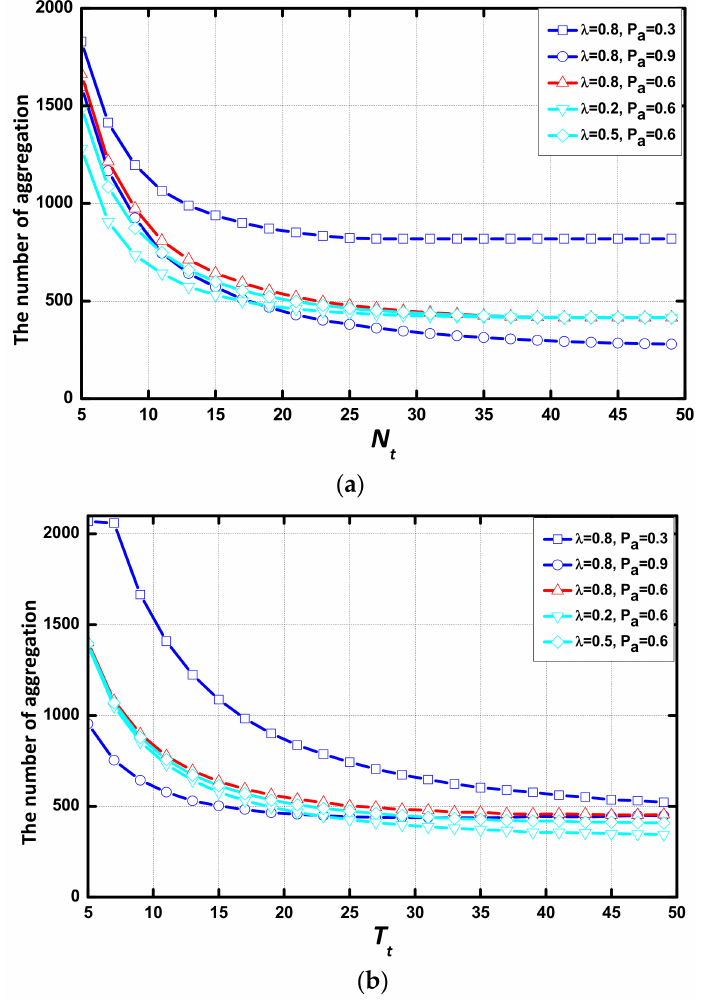
Figure 12. Average delay with different ( λ , P α ) when ( m , N ) = (3,20) ( a ) Average delay vs. N t ; ( b ) Average delay vs. T t